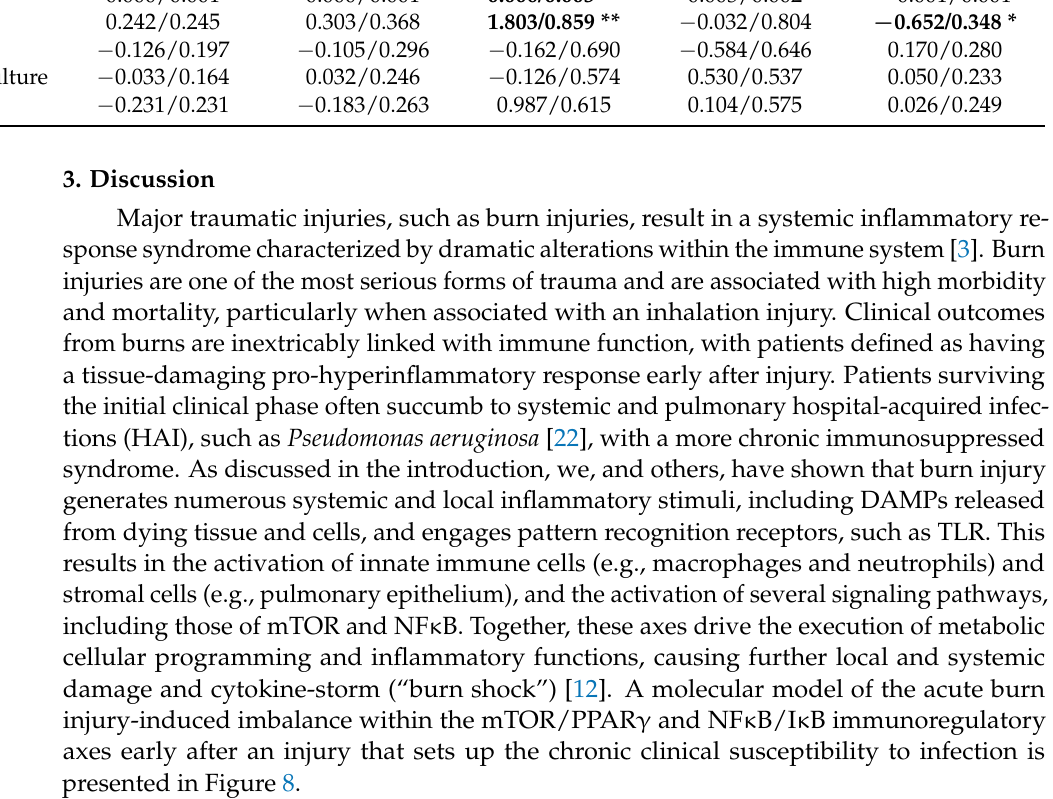
Table 2 lists the parameter estimates, standard error, and p -values for the covariates in the model, based on the Wald test. Taking each gene in turn, DEPTOR gene levels are significantly associated with BMI ( ˆ β , the estimated β coefficient, =0.013, p = 0.049) and the presence of inhalation injury ( ˆ β = 0.343, p = 0.099). LAMTOR5 ( ˆ β = 0.026, p = 0.012), RPTOR ( ˆ β = − 0.23, p = 0.019), and PPAR γ ( ˆ β = 0.050, p = 0.024) were also significantly associated with BMI. RPTOR was also associated with patient death ( ˆ β = − 0.652, p = 0.075), MRC1 was